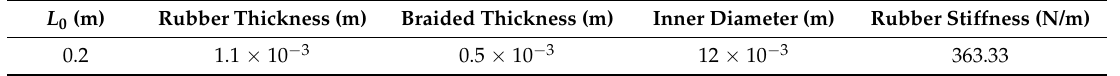
Table 1. The initial specifications of a 20 cm contraction PMA.